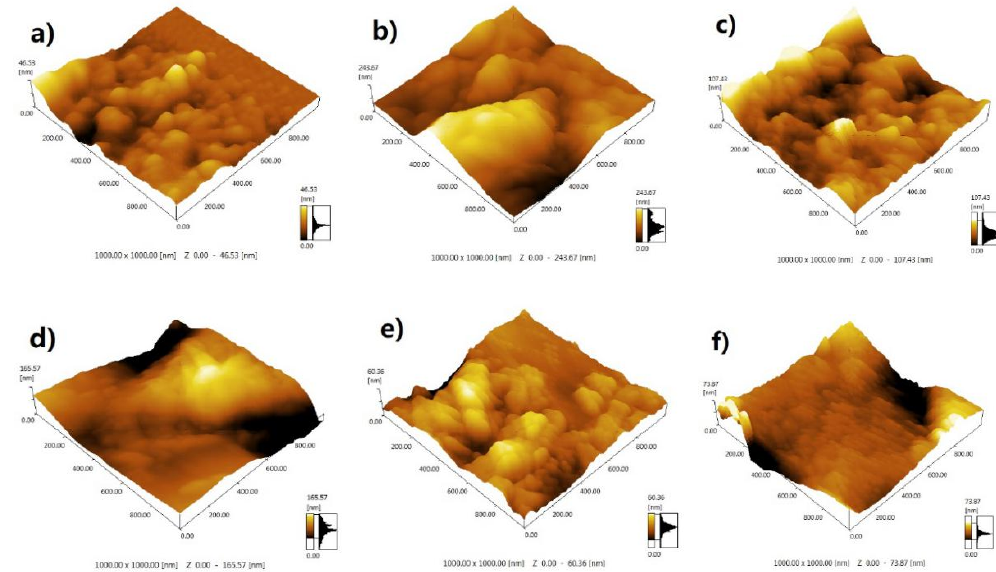
Figure 7. AFM images of untreated and irradiation treated Miscanthus biomass.